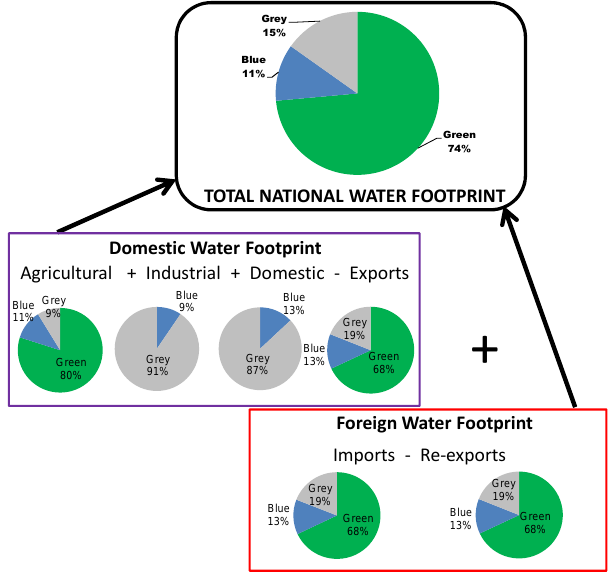
Figure 2. The composition of a national water footprint. It is composed of domestic goods and services plus imports (incoming water) minus exports (outgoing water). Each of these has green/blue/grey components. Data are from Hoekstra & Mekonnen (2012b) and show global averages to illustrate differences in water composition.